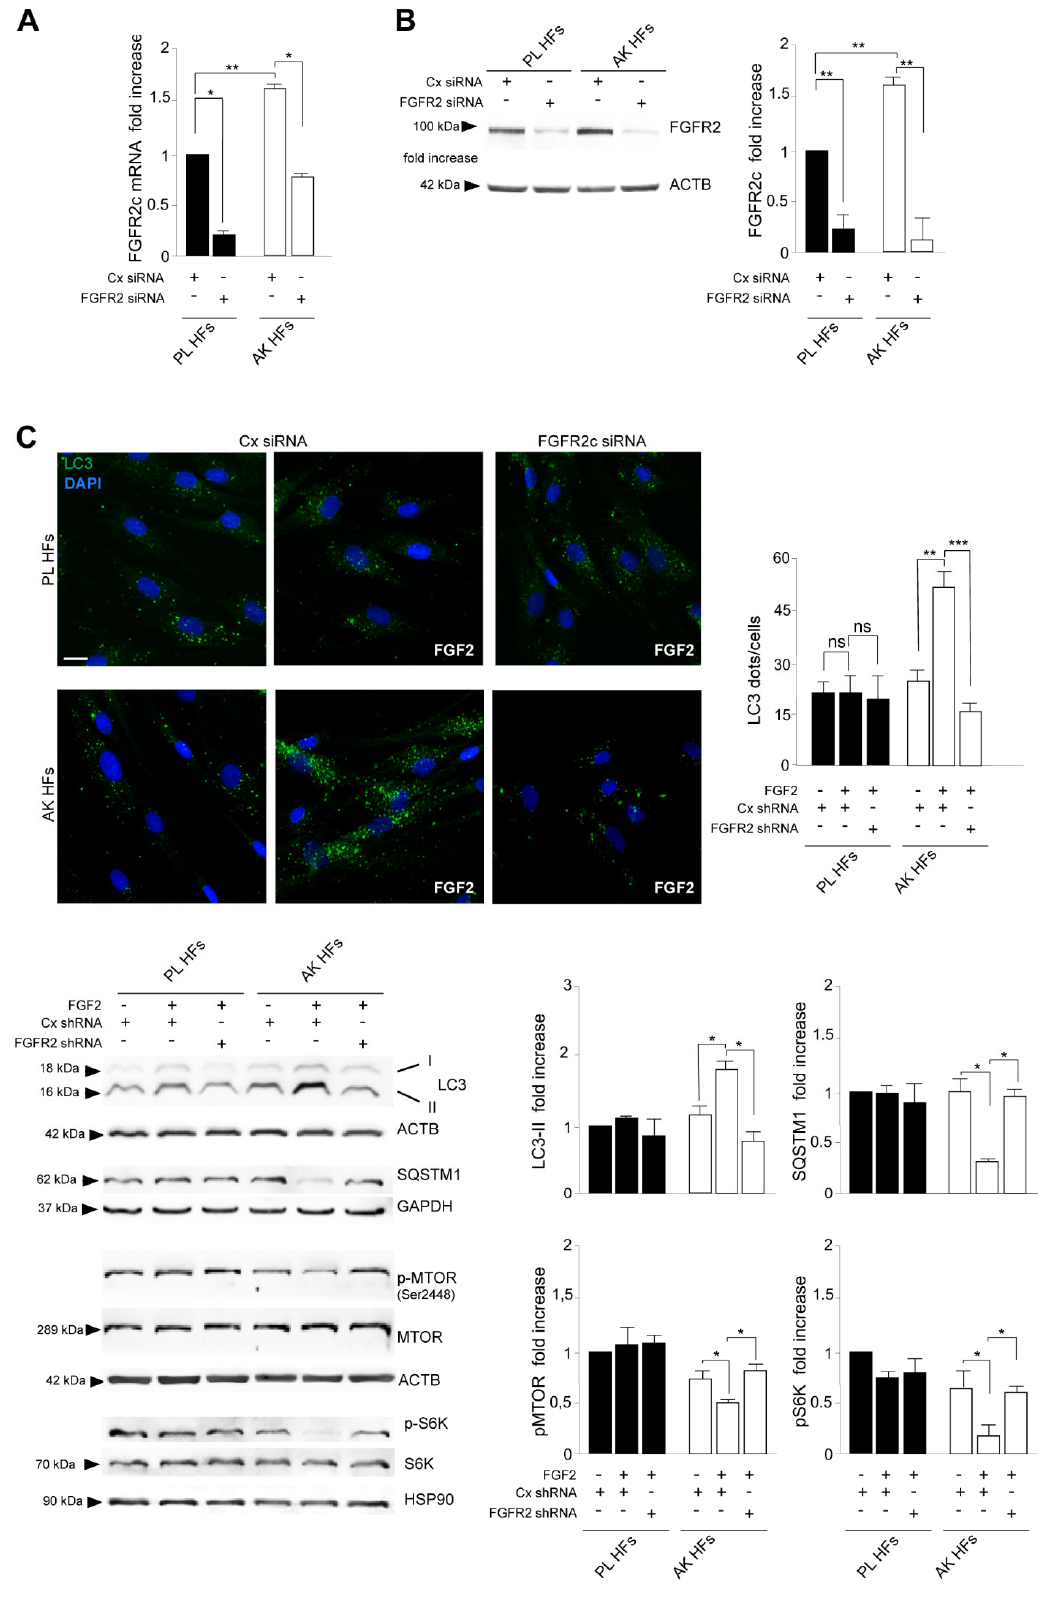
Figure 6. High expression of FGFR2c in KIN I-derived HFs is responsible for the increase of the autophagic process in response to FGF2. Primary culture of HFs isolated from #2PL and #2AK